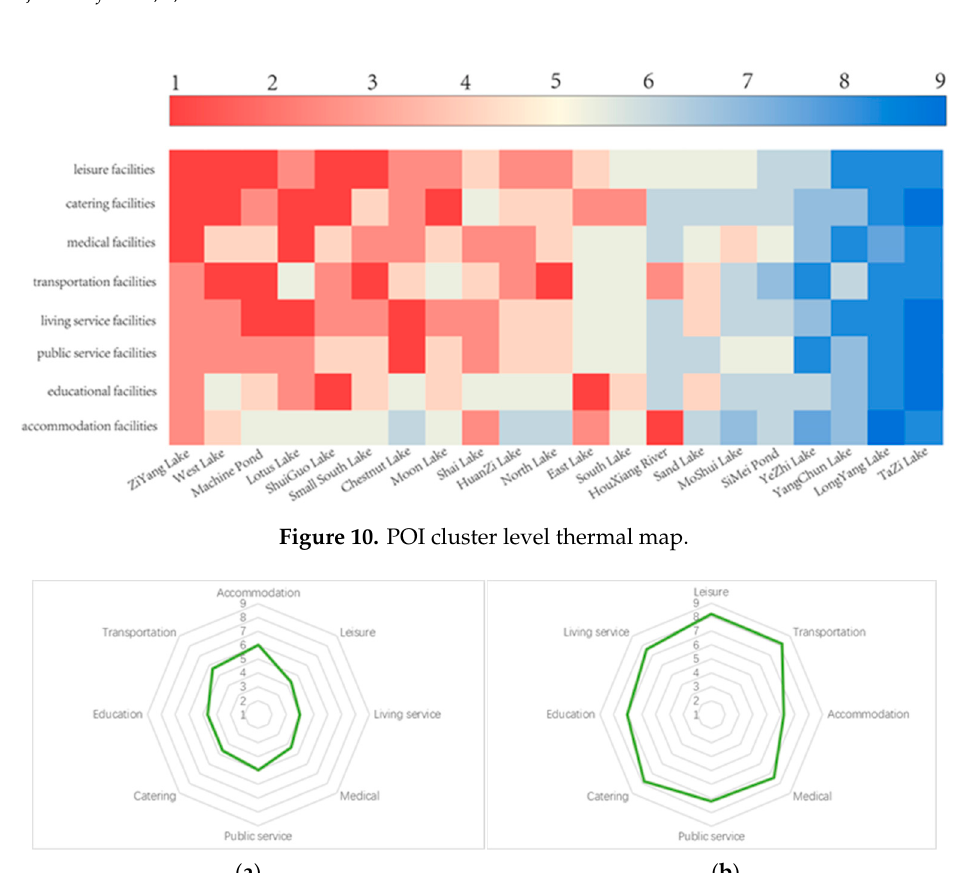
Figure 11. POI characteristics of lakes favored by users of different genders: ( a ) Various POI levels for the lakes that men prefer; ( b ) various POI levels for the lakes that women prefer.